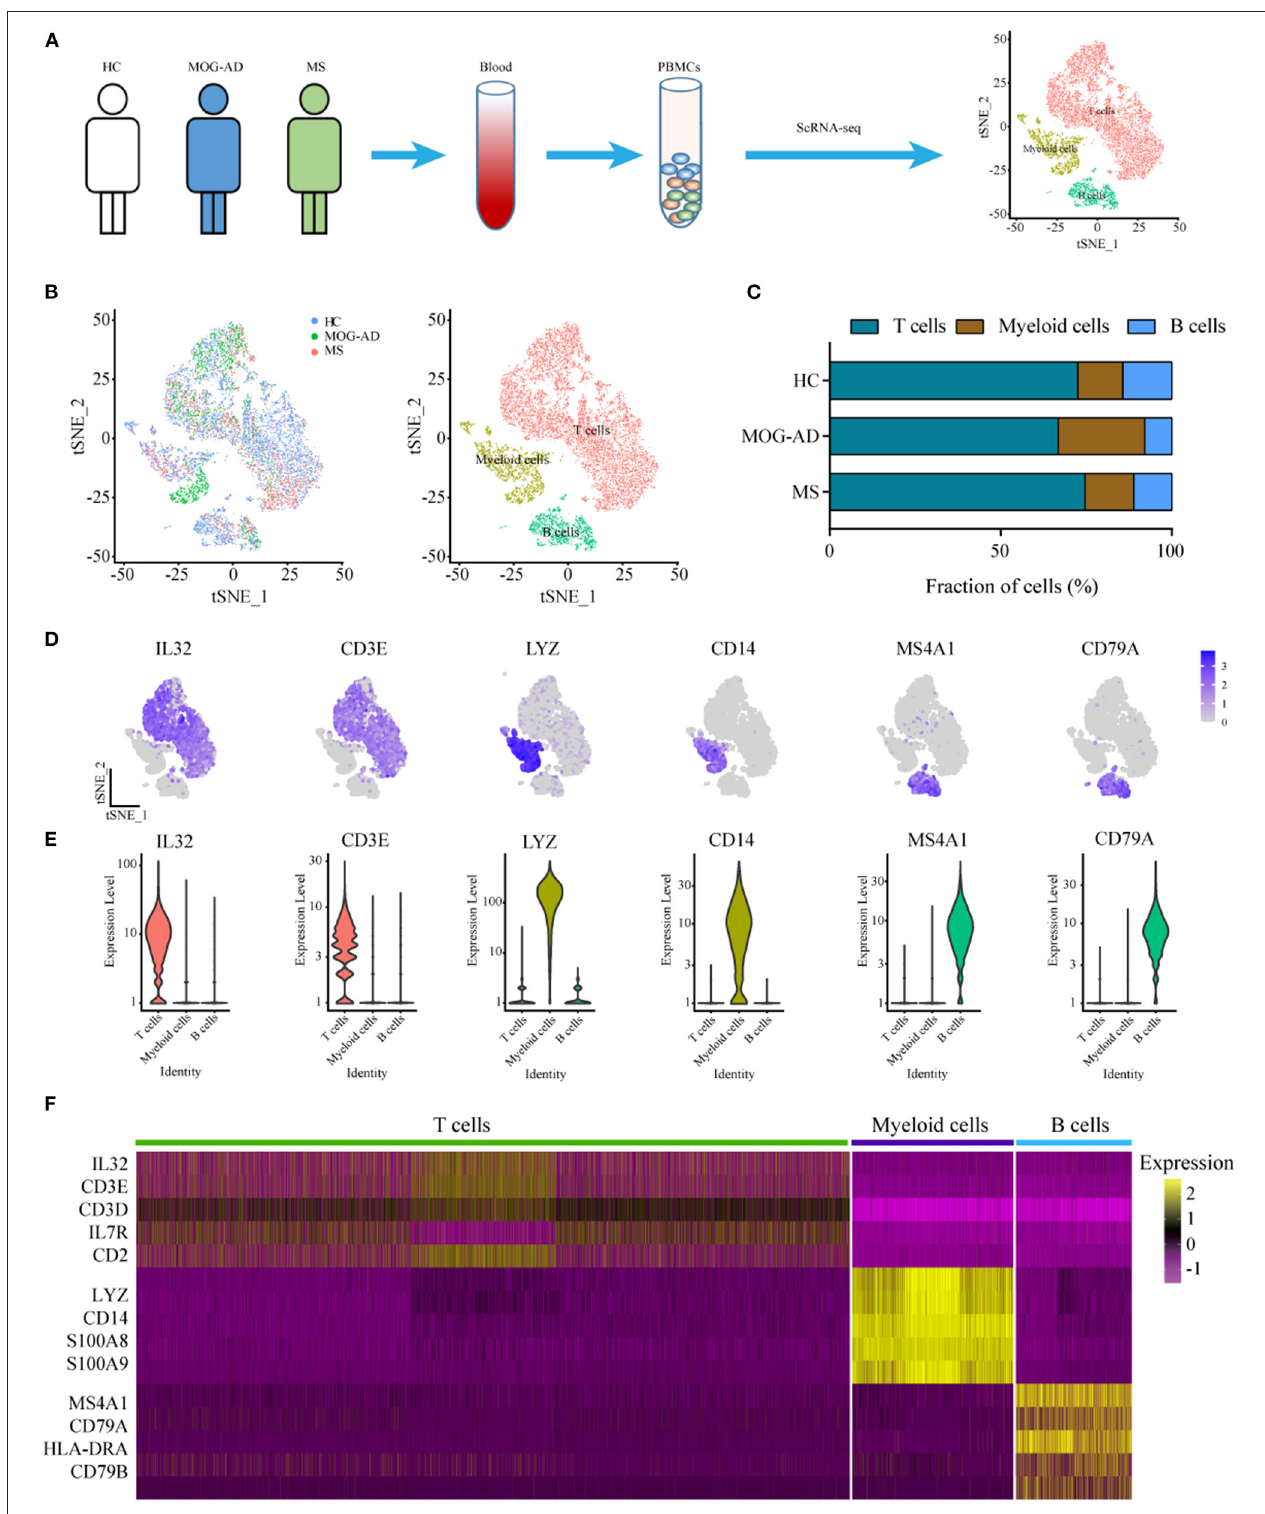
FIGURE 1 | Single-cell transcriptional profiling of PBMCs from HC, RRMS, and MOGAD. (A) The experimental workflow for obtaining and analyzing PBMC between all three donor groups. (B) The t-Distributed Stochastic Neighbor Embedding (tSNE) was used to visualize cell populations generated by unsupervised cluster analysis of PBMC. (C) The percentage of each cell type in HC, MS, and MOGAD. (D) The expression level of the marker gene in each cell type was shown. (E) Violin illustration shows the expression of marker genes from different known cell types. (F) Heatmaps shows the expression of the up- and downregulated genes in T, B, and